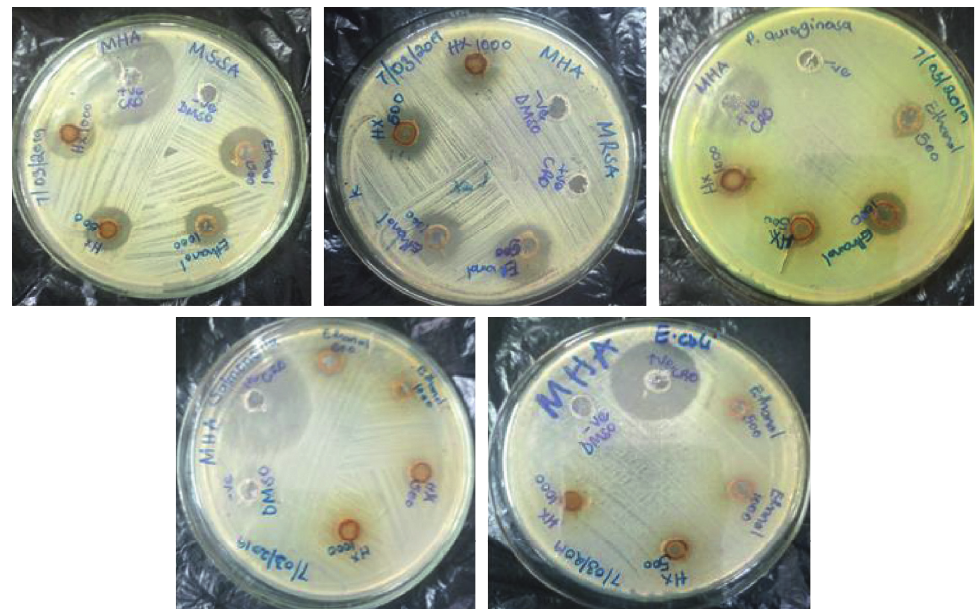
Figure 2: In vitro antibacterial activity of crude extracts of A. heterophyllus seeds against selected bacteria using agar well diffusion